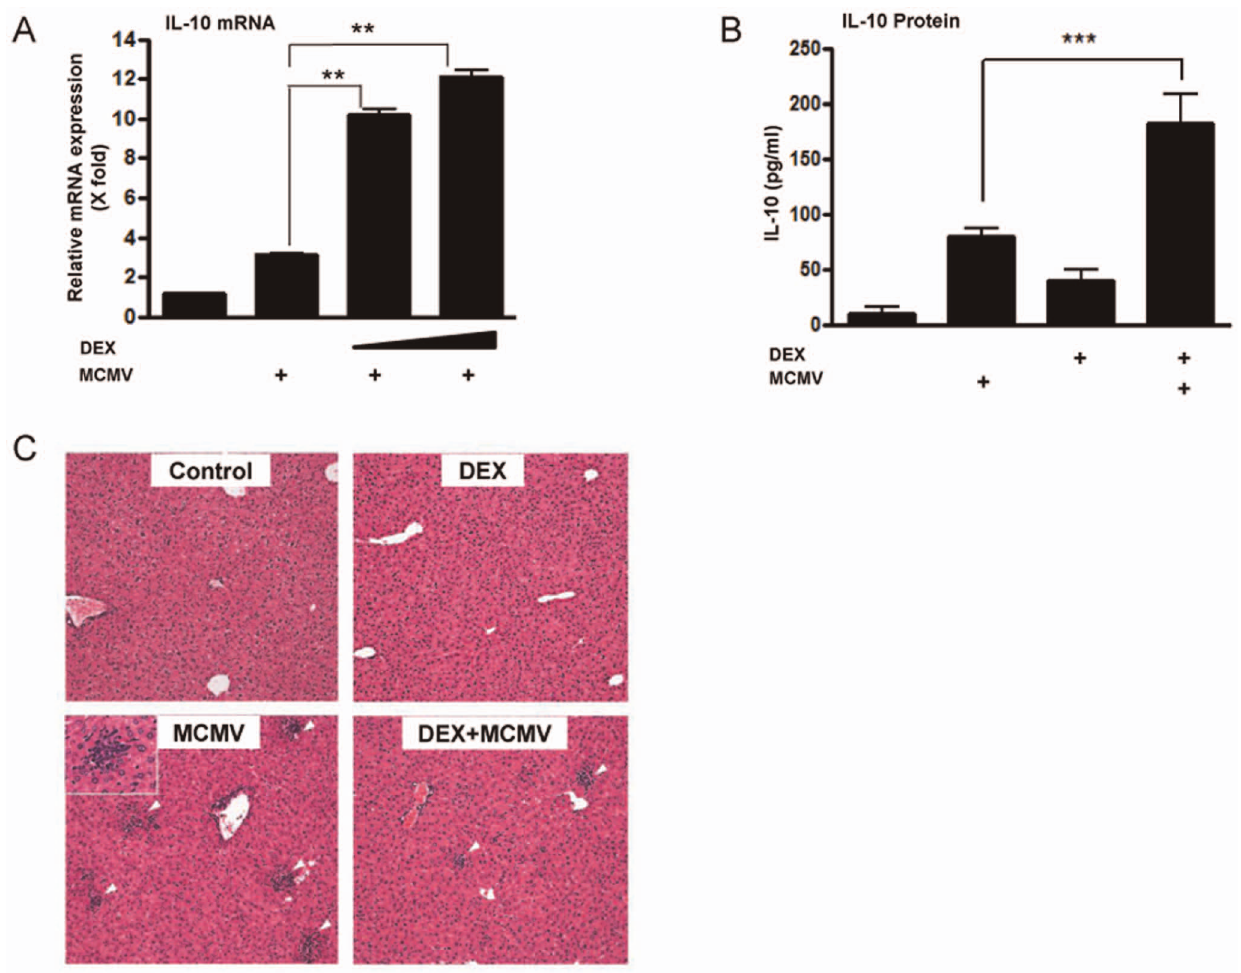
Figure 5. DEX pre-treatment and MCMV infection cooperatively induced IL-10 production invitro and invivo , and suppressed inflammation in the liver. A . DEX pre-treatment and MCMV infection cooperatively increased IL-10 mRNA expression in DCs. DCs were pre-treated with DEX (10 2 7 or 10 2 8 M) for 30 min, and were infected with MCMV (1 6 10 6 pfu) for 6 hours. Bars represent means and standard errors of fold changes of the IL-10 mRNA expression. **: p , 0.01, compared to the 2 conditions indicated. B & C . DEX pre-treatment and MCMV infection cooperatively induced IL-10 production in mice and suppressed inflammation in their livers. Female mice were pre-treated with DEX (0.3 m g/g animal) twice (at 24 hours and 1 hour prior to viral injection), and were infected with MCMV (1 6 10 6 pfu). Two days after the infection, sera and livers were collected. Panel B shows alternation in the serum IL-10 concentrations in mice, while panel C demonstrates representative images of the H&E staining of their livers (magnification 10 6 ). The inset of the left lower panel shows an inflammatory site in the liver caused by MCMV infection (magnification 40 6 ). Bars represent means and standard errors of the serum IL-10 concentrations obtained from three mice. ***: p , 0.001, compared to virus infection